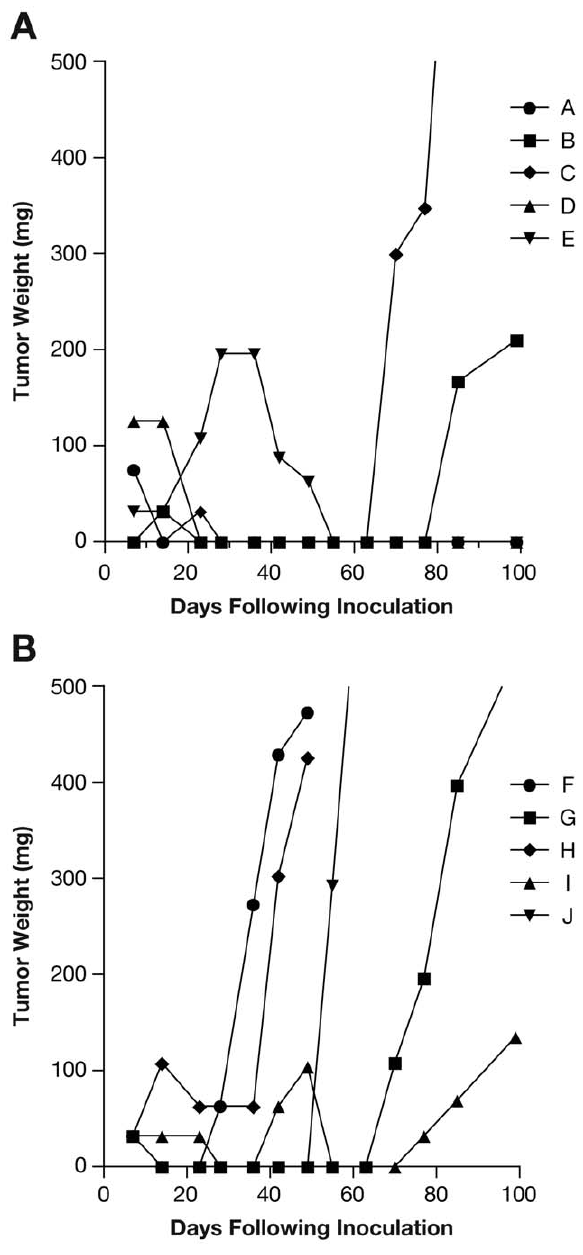
Figure 1. Effect of SC-1 on Tumor Formation in HCT-15 Colon Tumor Line with a 10 Cell Inoculum and Matrigel Co-injection. Limiting dilution tumorigenicity assay was performed with simulta- neous injection of Matrigel. A. Control treated HCT-15 tumor line. B. SC- 1 treated HCT-15 tumor line. Tumor weight for each mouse is depicted. Tumor formation was increased in SC-1 treated cells when 10 cells/ mouse were injected (SC-1 treated: 5 of 5 tumors formed, Control treated: 2 of 5 tumors formed). At higher cell inocula, all mice